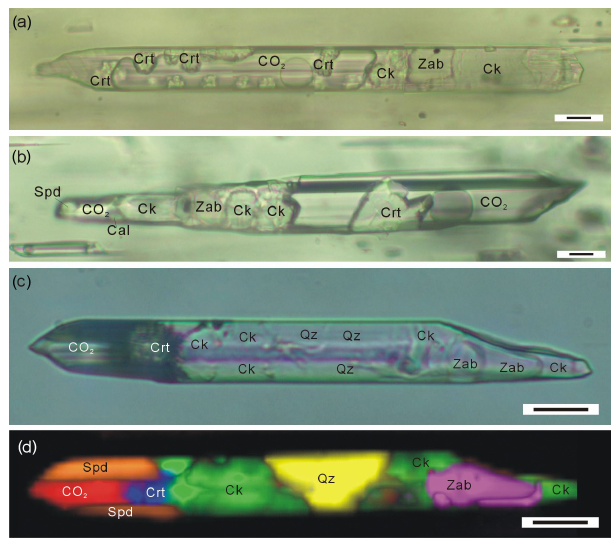
Figure 2. Crystal-rich inclusions (CIs) hosted in spodumene from the Jiajika deposit. Crt – cristobalite, Spd – spodumene, Zab – zabuyelite; Cal – calcite, Qz – quartz; Ck – cookeite. (d) Raman map of the CI shown in (c) . The length of the scale bar is